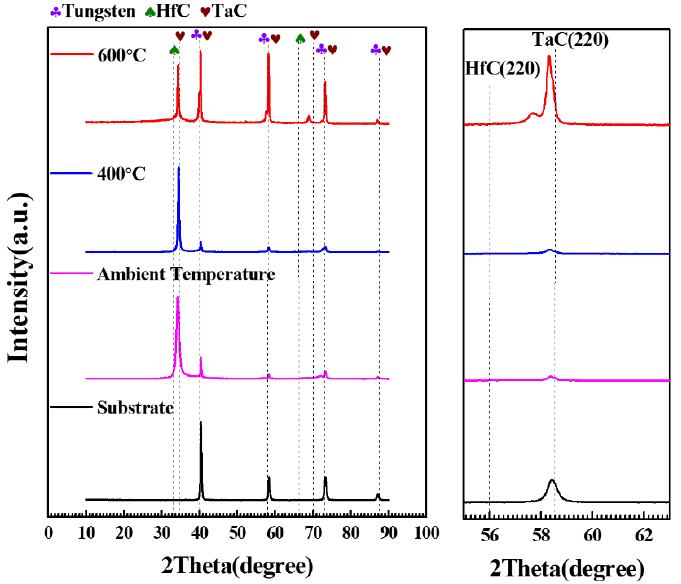
Figure 6. XRD patterns of Ta-Hf-C coatings under different deposition temperatures.